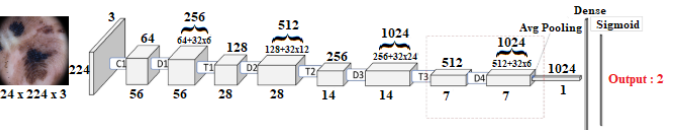
Figure 5. The fine-tuning of proposed method of pre-trained DenseNet121 and DenseNet201